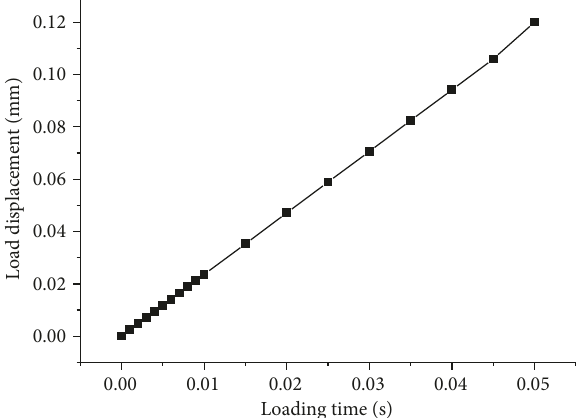
Figure 14: The load curve of dynamic tensile